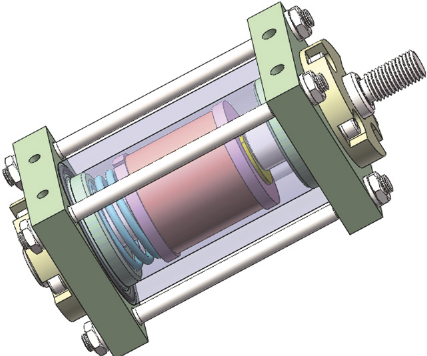
Figure 2: 3D model of the MRF